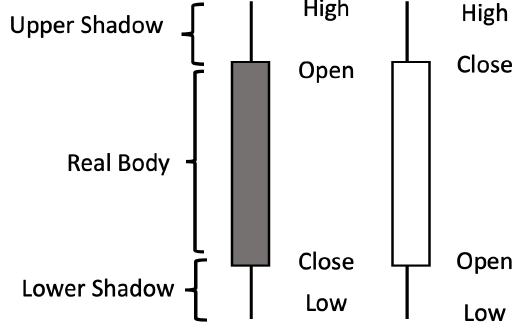
Figure 2. The structure of candlesticks